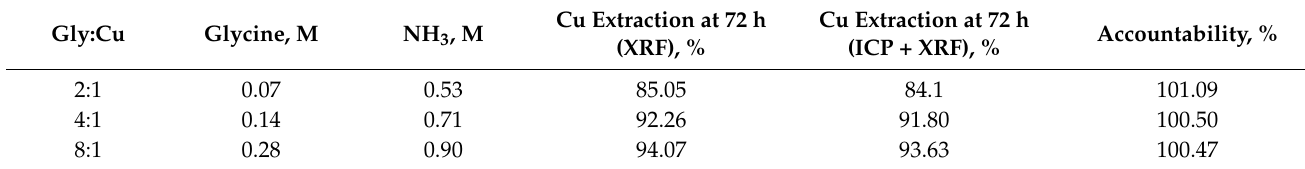
Table 5. Reagent dosages and final Cu extraction at different Gly:Cu molar